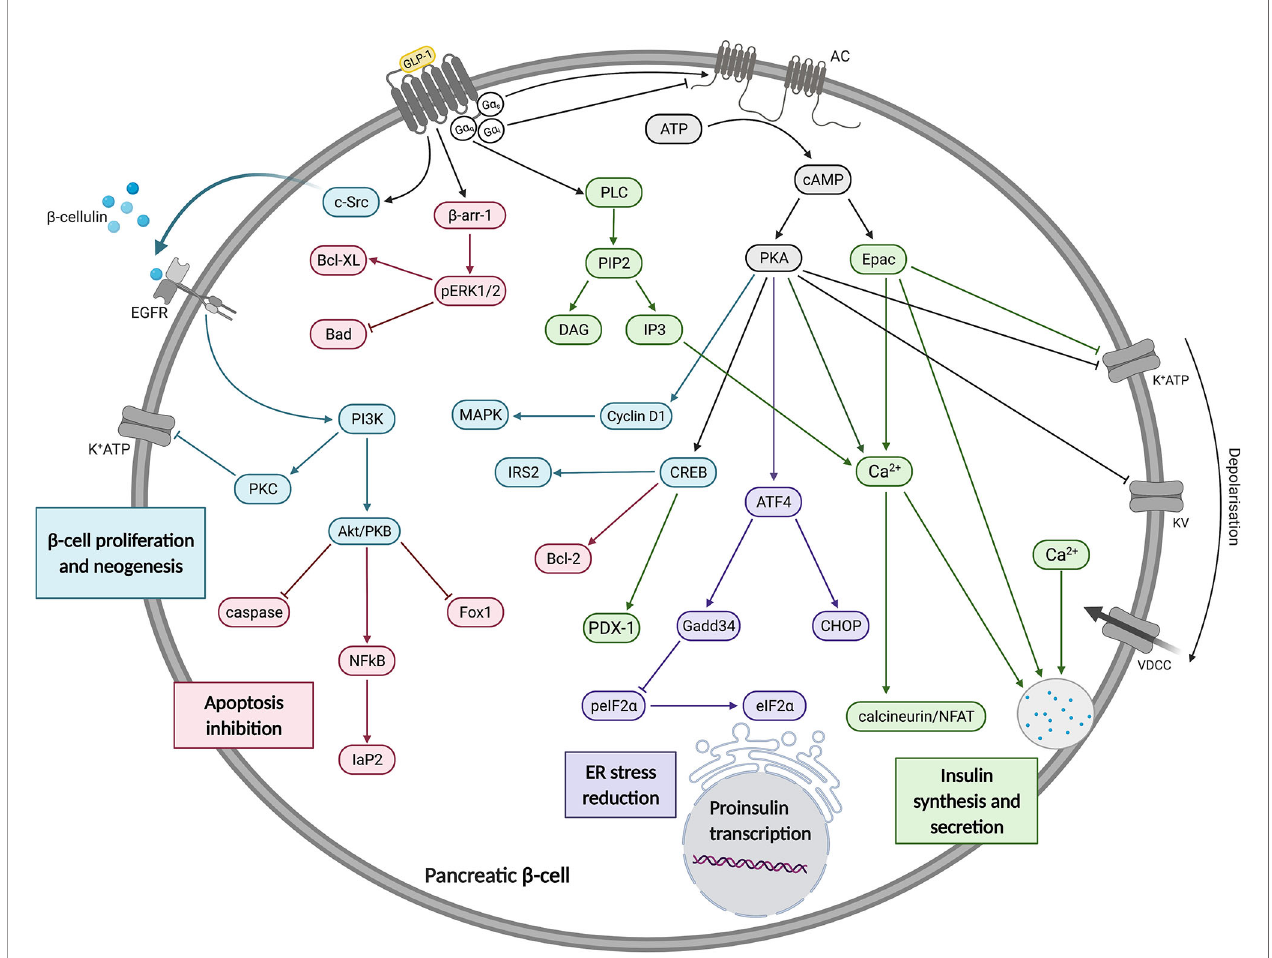
FIGURE 1 | A summary of the effects of GLP-1 on insulin synthesis, secretion, beta cell proliferation, neogenesis and apoptosis inhibition. In pancreatic beta cells, GLP- 1R signalling is predominantly via G a s which mediates increases in cAMP to activate Epac and PKA. These have a range of effects, as described in the main text and depicted in this fi gure. These and other pathways promote increases in insulin gene transcription, synthesis and secretion. Figure created using